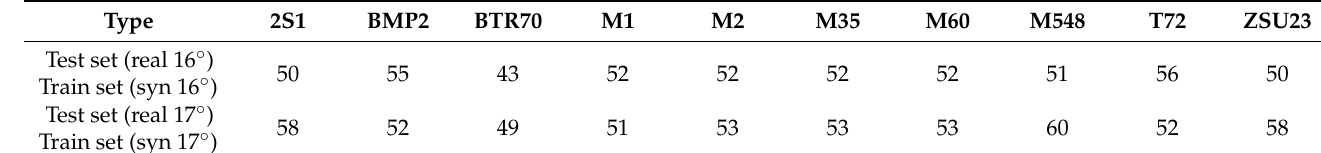
Table 1. Number of SAR images in the test and training sets of the SAMPLE dataset.